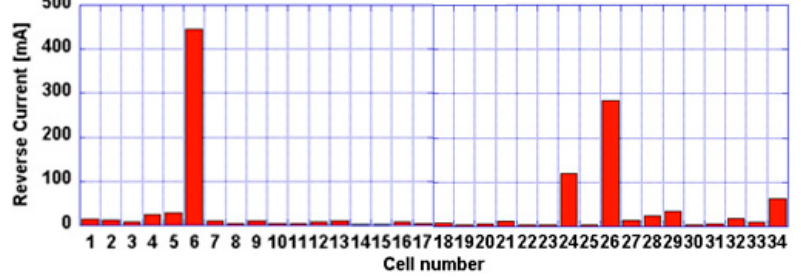
Figure 2. The current value in each cell energized at − 10 V in dark conditions. It can be observed that